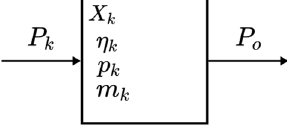
Figure 6. Definition of single component, 𝑋 (cid:3038) .